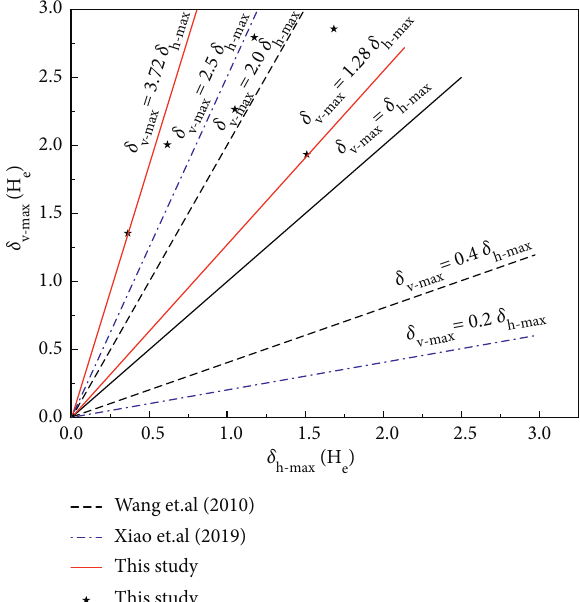
Figure 15: Relationship between the maximum ground settlement and maximum displacement of retaining wall.